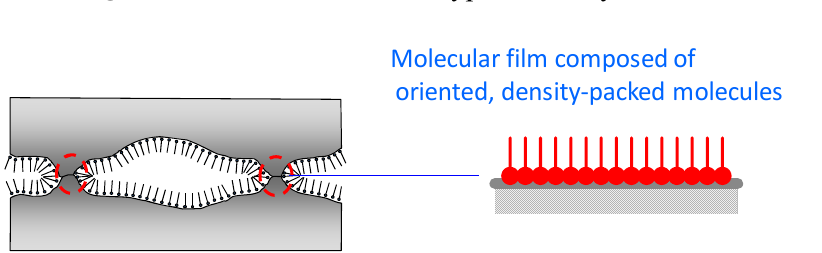
Figure 2. The Bowden-Tabor type boundary film model.